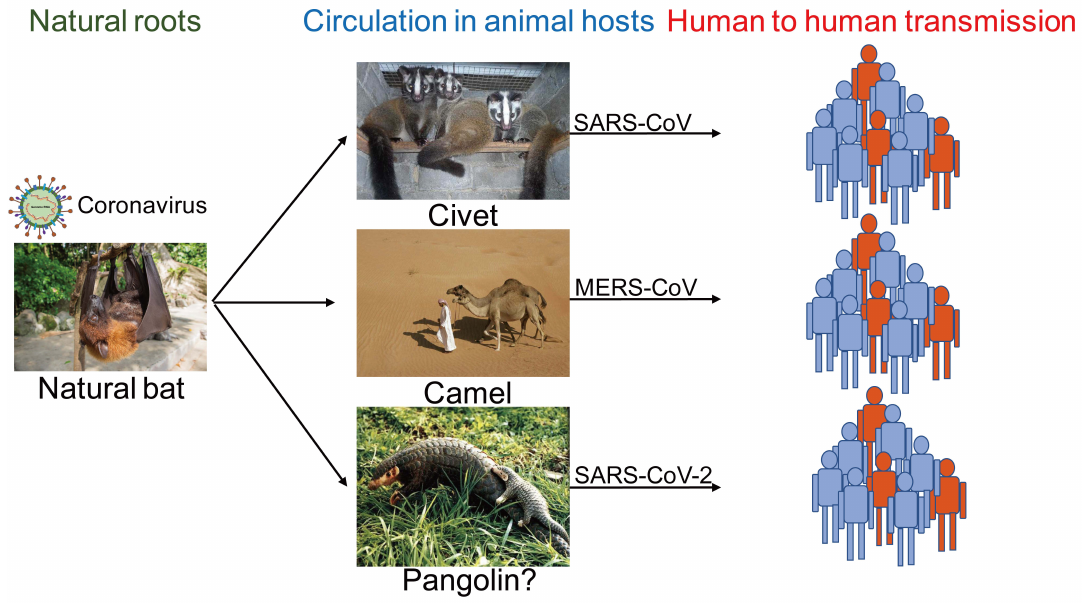
Figure 3. Ecology of emerging coronaviruses SARS-CoV, MERS-CoV, and SARS-CoV-2 are all bat origin coronaviruses, which cause human infections after circulation in animal hosts of civet, camel, and